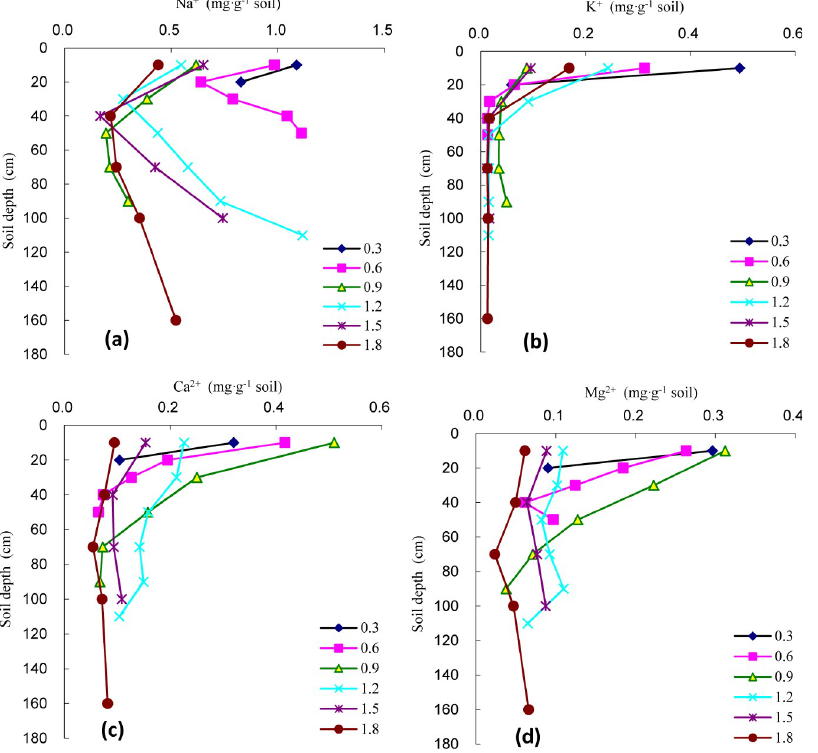
Fig 2. Changes of soil salt cation under different groundwater level in soil profiles. (a) Na + ; (b) K + ; (c) Ca 2+ ; (d) Mg 2+ .